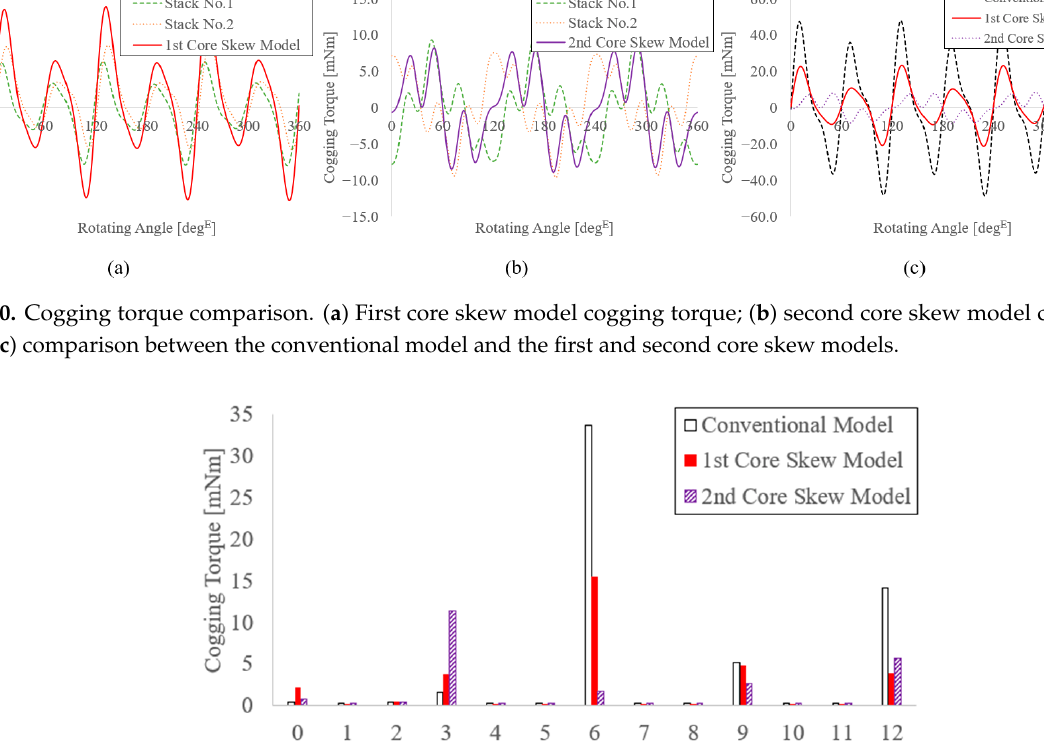
Figure 11. Spectra of cogging torque for each model.